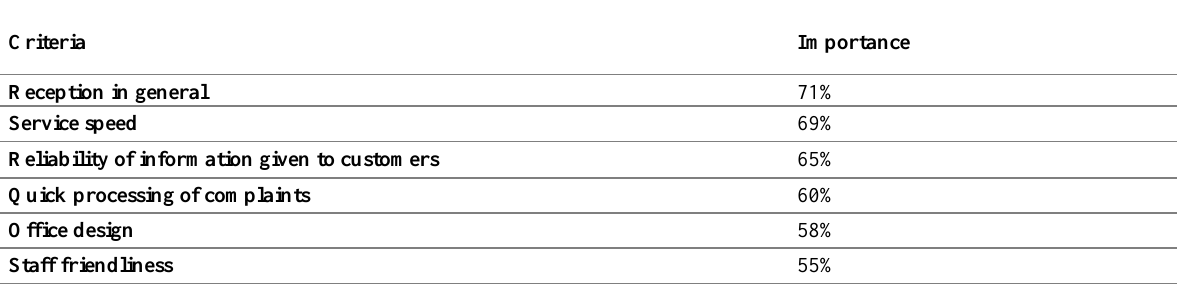
Table 6: Degree of importance of quality criteria according to